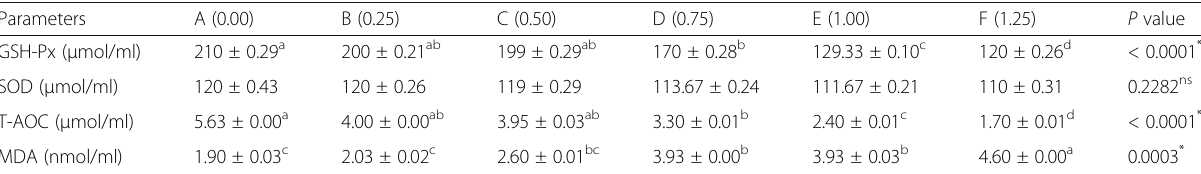
Table 4 Antioxidant status of the broilers fed diets with different levels of MSG Parameters